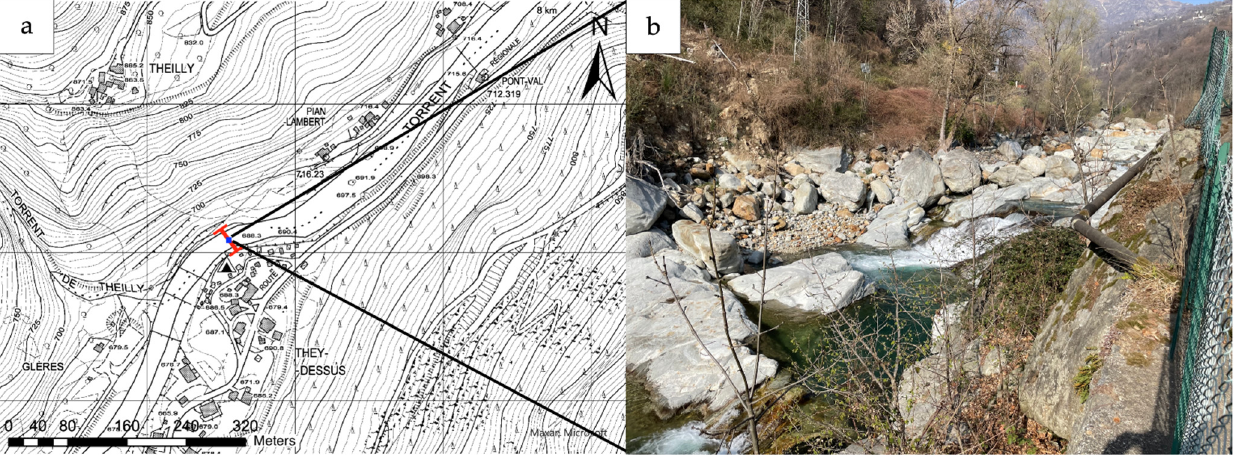
Figure 3. ( a ) Detail of the 1:5000 topographic map representing Theilly area; the critical section is highlighted in red and the point used for DTM analysis is represented in blue; ( b ) Photograph of the critical section, where an anthropic element is present.